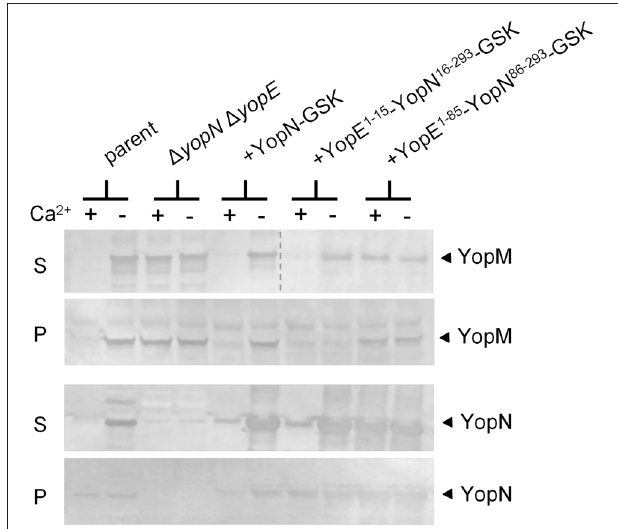
FIGURE 1 | The YopN CBD but not the N-terminal secretion signal is required to regulate Yop secretion. Immunoblot analysis of culture supernatant (S) and cell pellet (P) fractions of Y. pestis KIM8.P39 (parent), KIM8.P62 ( (cid:2) yopN (cid:2) yop E ), and KIM8.P62 expressing YopN-GSK, presence ( + ) or absence ( − ) of 2.5mM calcium for 5h at 37 ◦ C. Antisera specific for YopN or YopM were used to detect the expression and secretion of the respective proteins. The dashed line indicates the margins of two blots shown in a merged